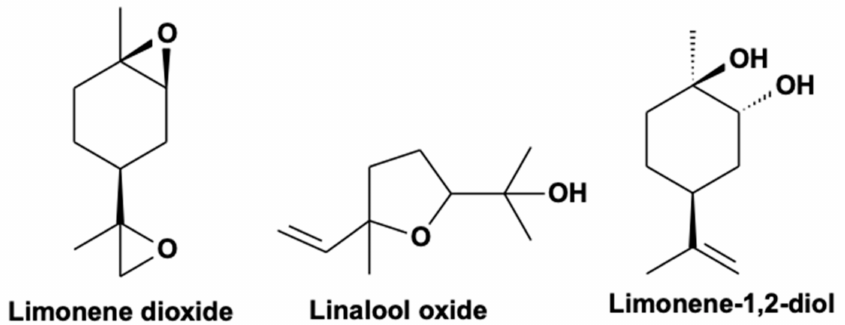
Figure 2. Biotransformation products with insecticidal properties obtained though fermentation of limonene